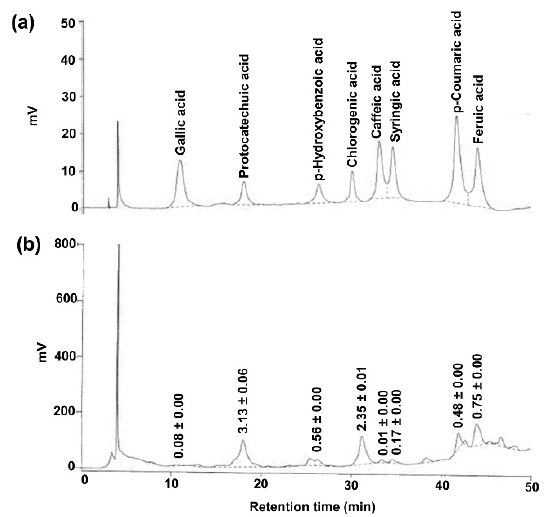
Figure 1. HPLC chromatogram at 280 nm showing major phenolic acids of purple rice husk extract. ( a ) Reference standards; ( b ) purple rice husk extract. The chromatographic peaks of the extract were confirmed by comparing their retention time and UV spectra with those of the reference standards. Numerical values denote the amount of individual compounds detected. Data (mean ± SD, n = 3) are expressed in mg/g of the extract.